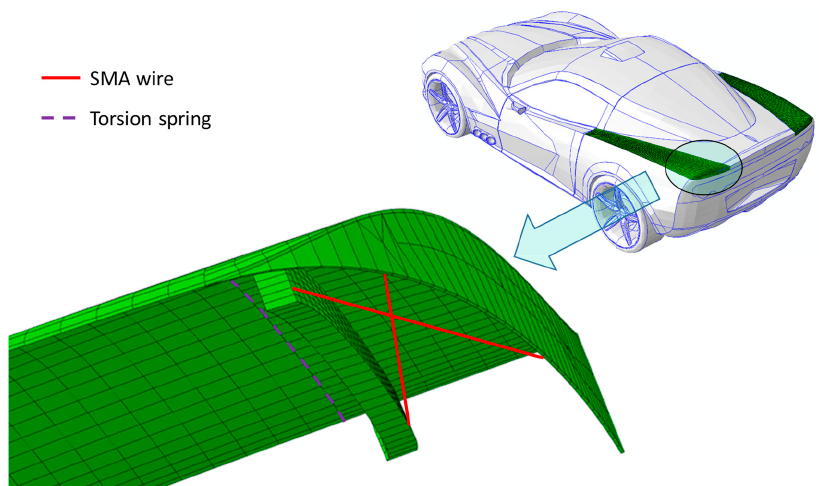
Figure 10. Rear upper panel actuation, details of the numerical model, and locations of SMA and torsion spring.